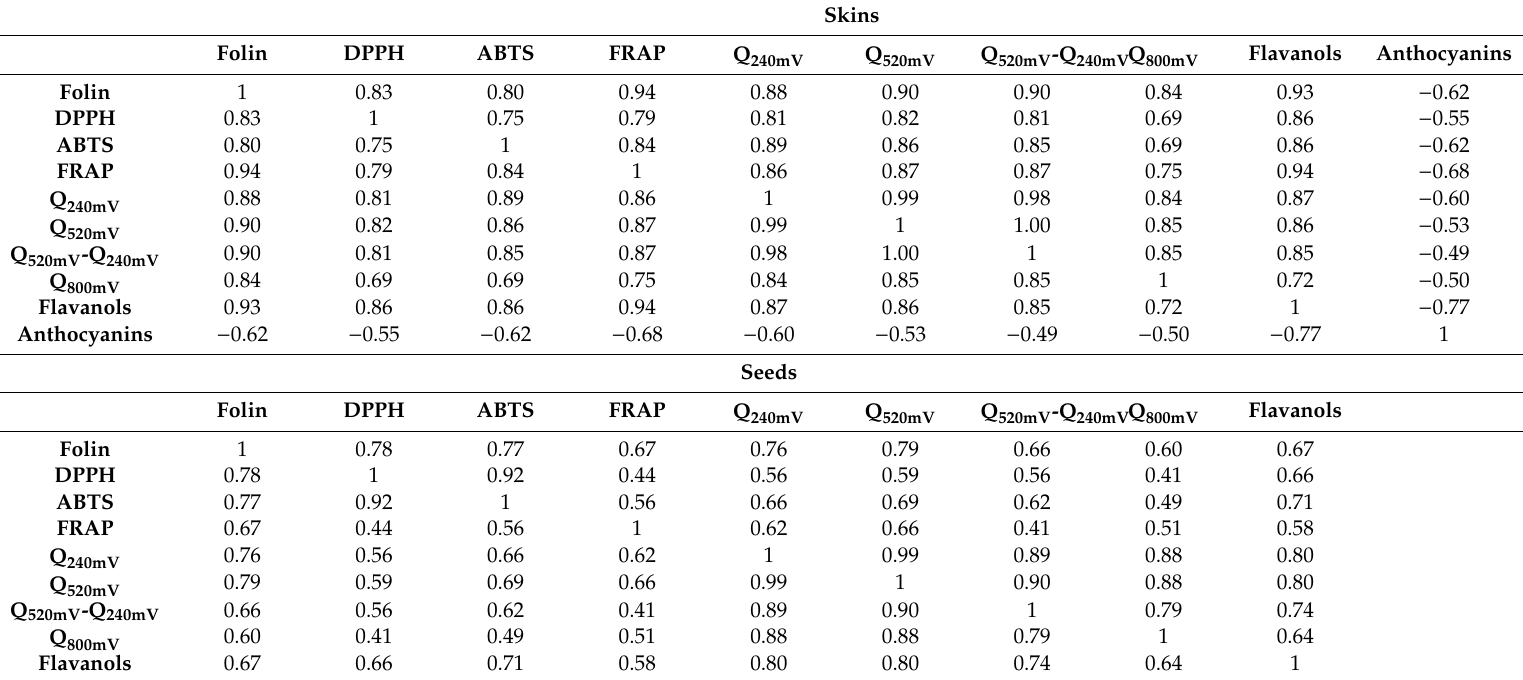
Table 5. Pearson’s correlation coe ffi cients of antioxidant capacity using spectrophotometric tests, electrochemical parameters, flavanols, and